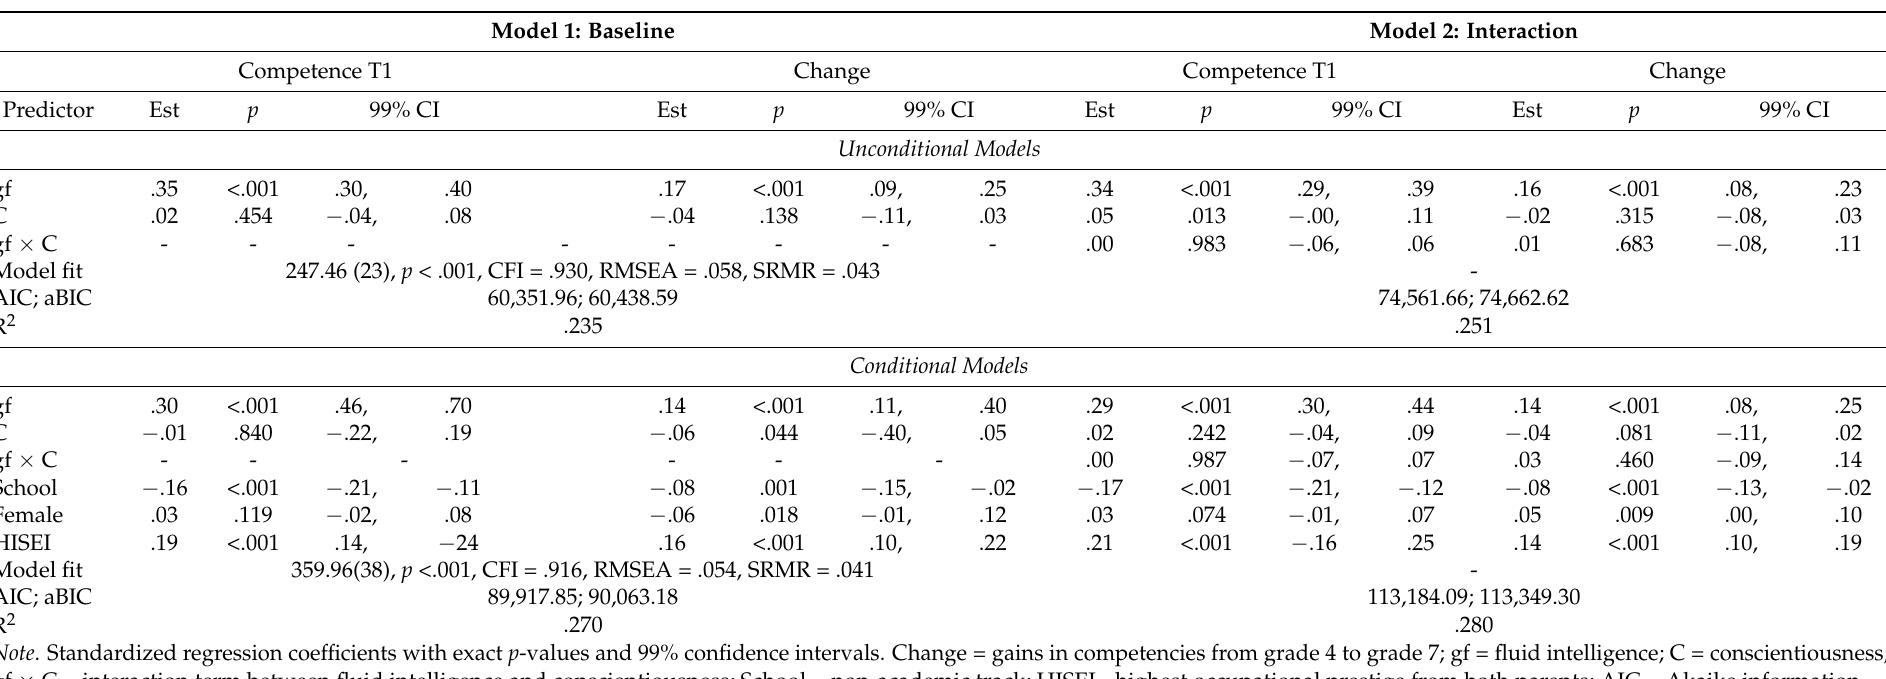
Table 3. Latent change score models predicting reading competence baseline levels and gains in